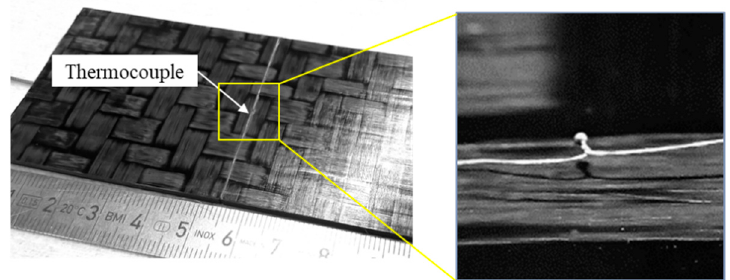
Figure 7. Thermocouple placement on the laminate and a magnified photo of the K-type thermocouple sensing end.